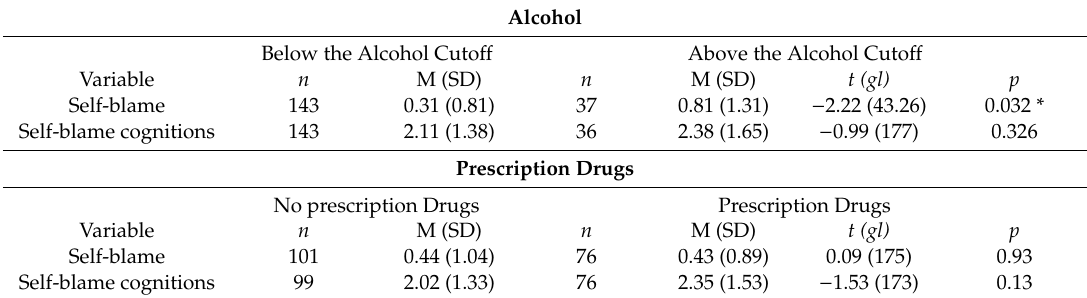
Table 4. Descriptive statistics and paired t -test for alcohol consumption and prescription drugs